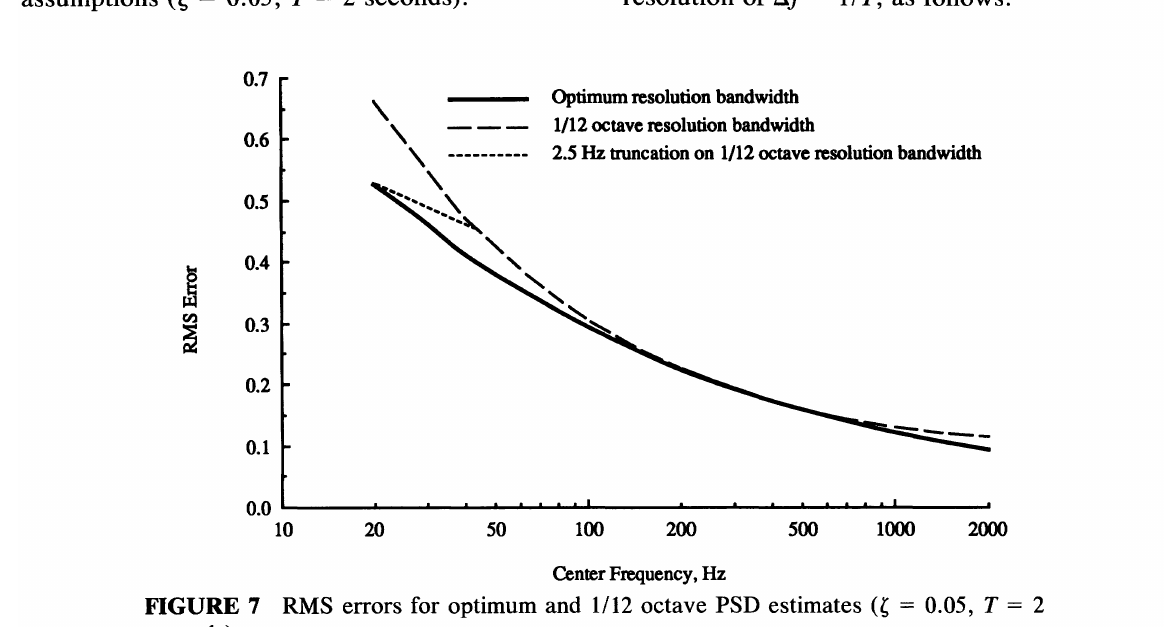
FIGURE 7 RMS errors for optimum and 1112 octave PSD estimates (' = 0.05, T = 2